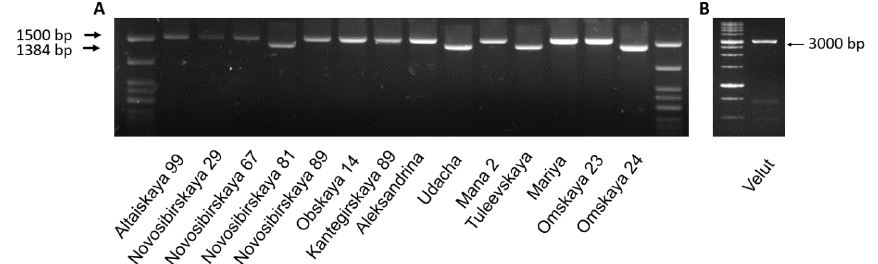
Figure 1. ( A ) PCR amplification using FTpr-F//R primers differentiating vrn-B3 (1384 bp) and Vrn-B3e (1500 bp) alleles; ( B ) PCR amplification with FTpr-F//R and the ‘Velut’ line.